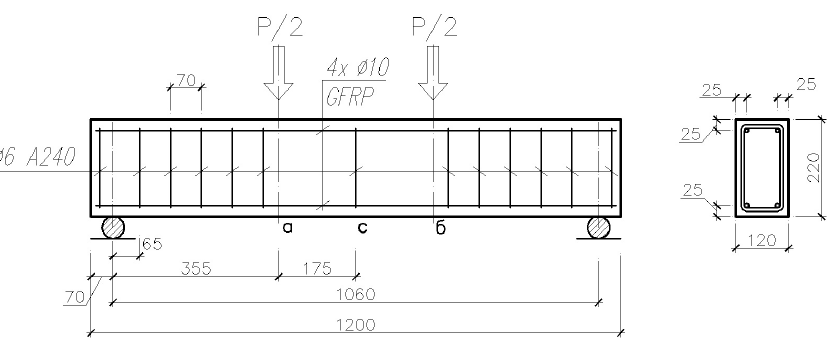
Figure 5. Concrete beam reinforcement